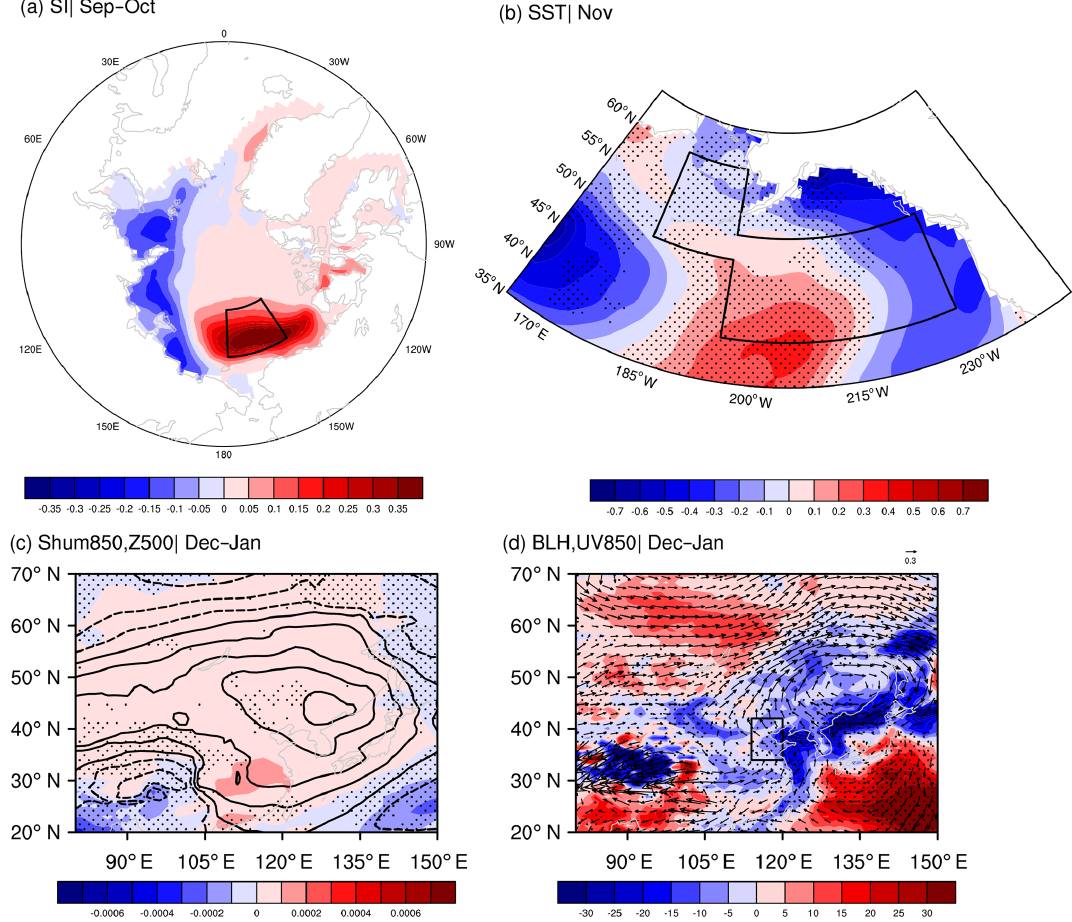
Figure 16. Composite difference of (a) September–October sea ice concentration, (b) sea surface temperature in November, (c) geopotential height (contour) at 500hPa, surface specific humidity in December–January, (d) BLH (shading) and surface wind (arrow) in December– January. The black box in panel (a) represents the location of the Beaufort Sea, and in panel (b) it represents the BA area. Results are based on 35 ensembles of CESM-LE simulations. The black dots indicate that the mathematical sign of the changes with shading from more than 50% of the members are consistent with the ensemble